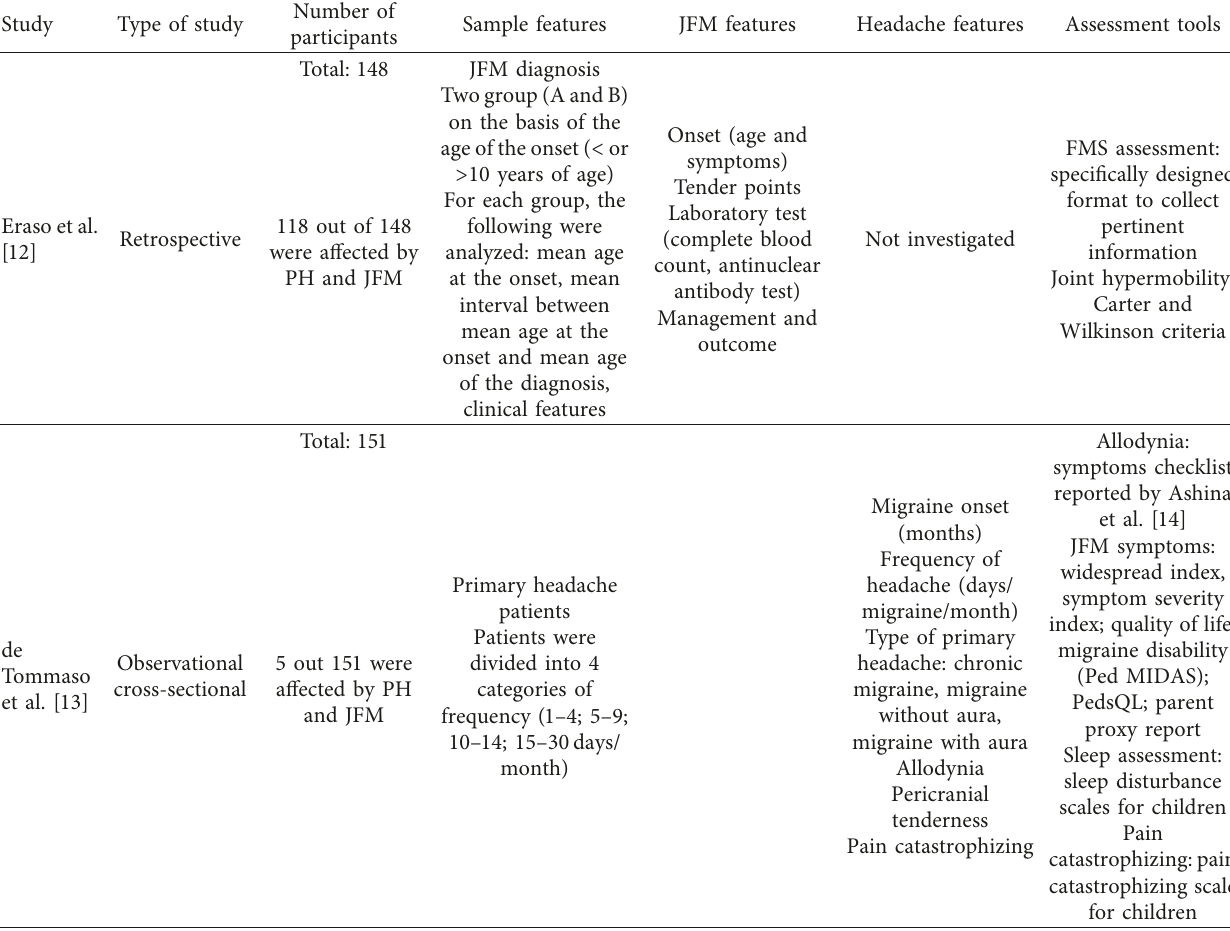
Table 1: Features of the studies